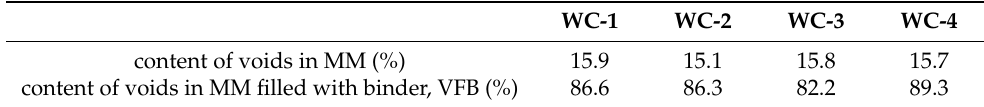
Table 12. Content of voids in MM and in the MM filled with binder for particular series.